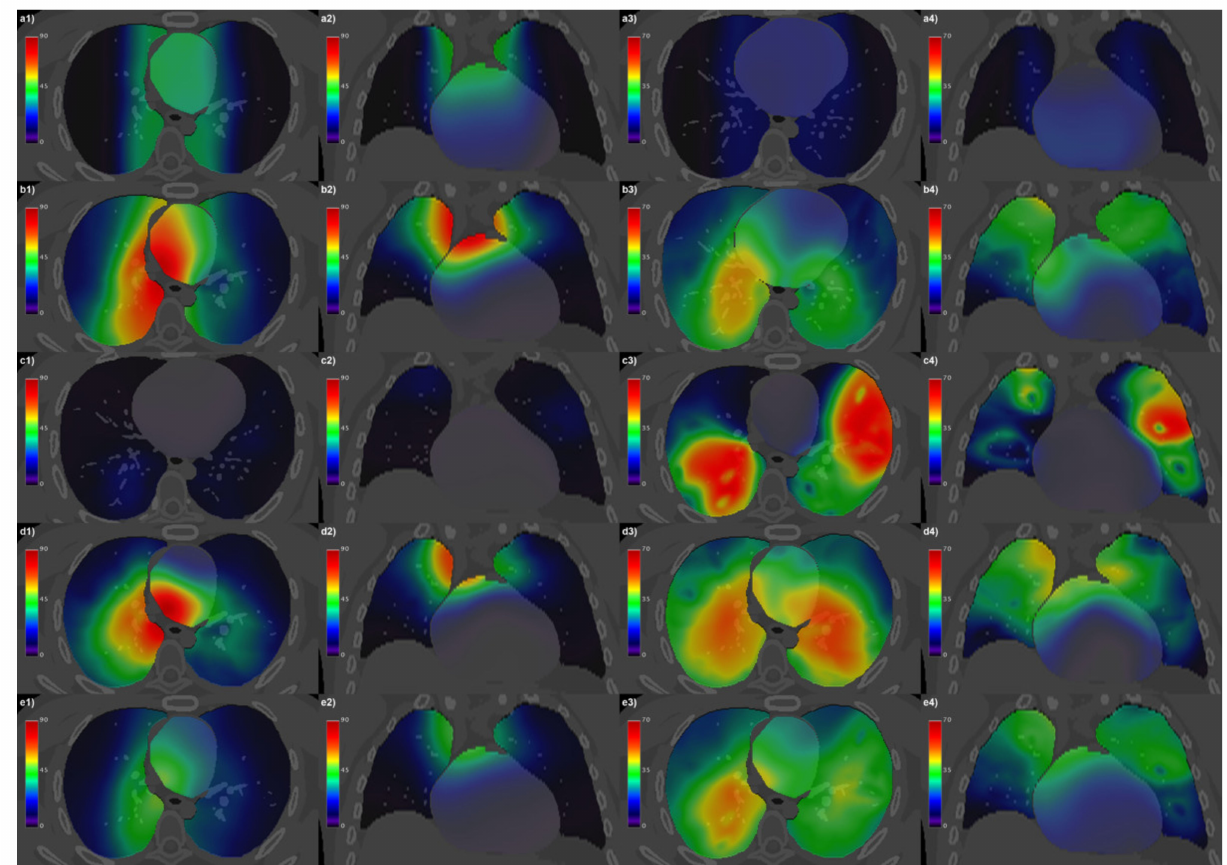
Figure 1. Axial ( columns 1 and 3 ) and coronal ( columns 2 and 4 ) CT views of the reference anatomy fused with mean ( columns 1 and 2 ) and standard deviations ( columns 3 and 4 ) of BED maps computed voxel by voxel over the patients for the Hodgkin lymphoma group ( row a ), non-small cell lung cancer (NSCLC) patients treated with intensity-modulated radiation therapy ( row b ), NSCLC patients treated with stereotactic body RT ( row c ), NSCLC patients treated with passive-scattering proton therapy ( row d ), and the whole cohort of patients ( row e ).